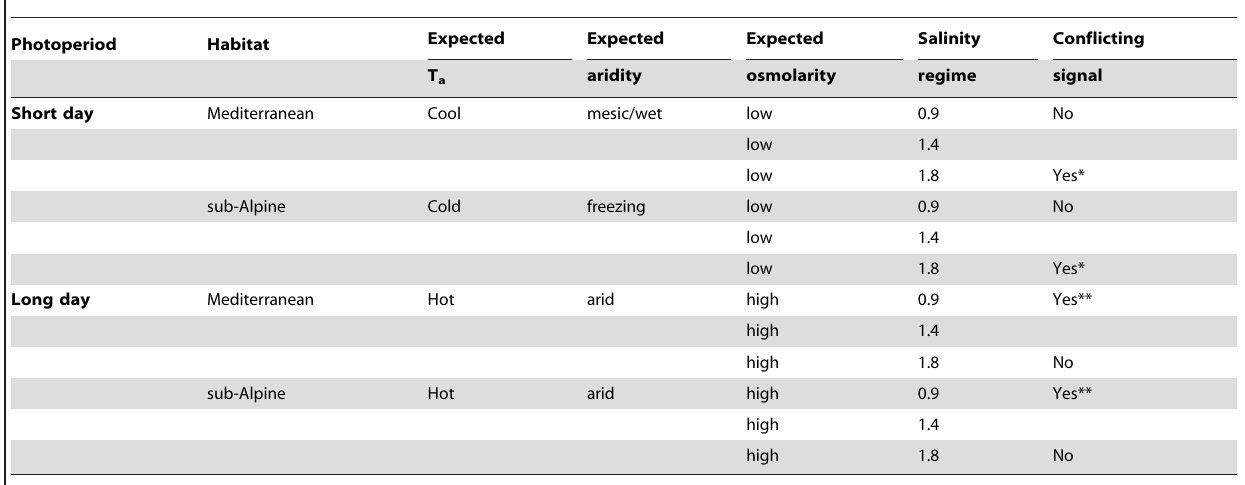
Table 2. Expected ambient conditions for each